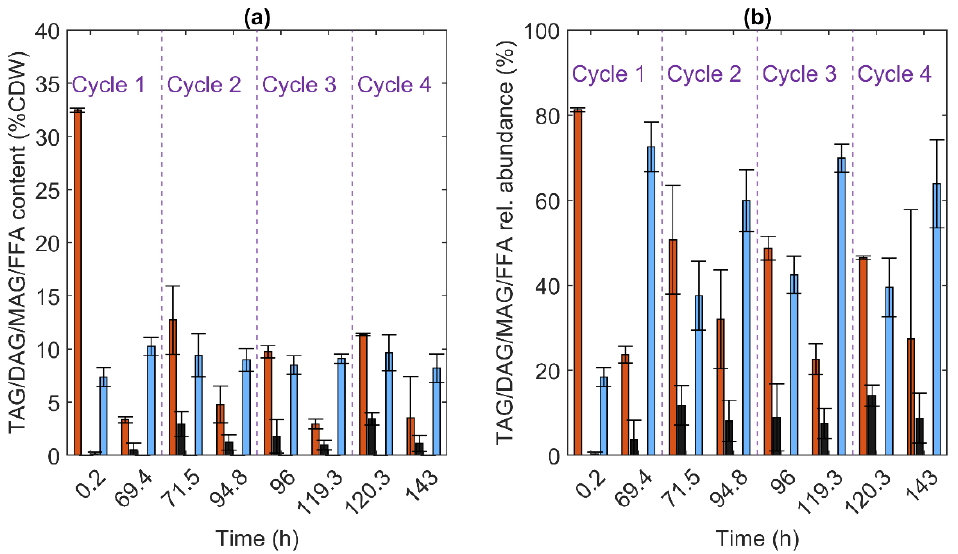
Figure 7. Evolution of ( a ) the %CDW of lipids and ( b ) the relative abundance of lipids, with ( ■ ) triacylglycerides (TAGs), ( ■ ) diacylglycerides (DAGs), ( □ ) monoacylglycerides (MAGs), and ( ■ ) free fatty acids (FFAs) for C. oleaginosum during the fermentation. Vertical dashed lines (--) indicate the end of each cycle. The %CDW and relative abundance are the averages of three analytical repeats, the error bars present the standard deviation. Outliers, points that were three scaled median absolute deviations away from the median of its group, were removed.